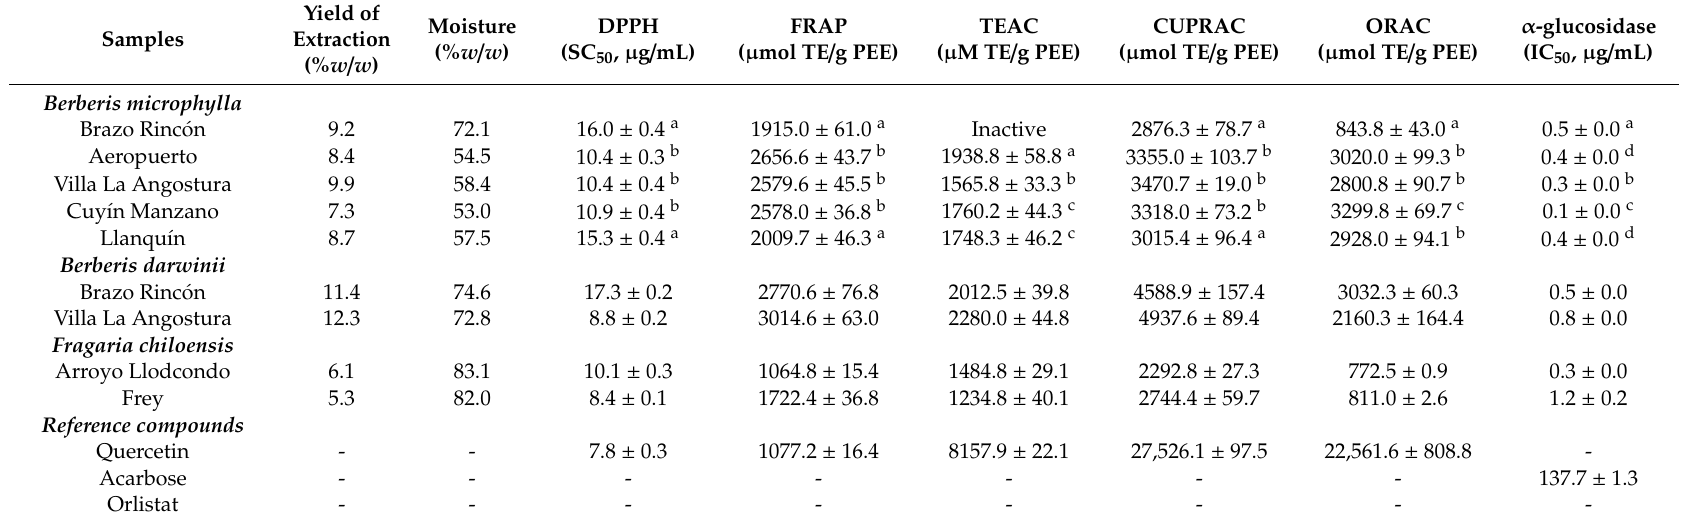
Table 1. Antioxidant capacity and inhibition of metabolic syndrome-associated enzymes by the phenolic enriched extracts (PEE) of wild berries from Argentinean Patagonia. DPPH = 2,2-diphenyl-1-picrylhydrazyl radical, FRAP = ferric-reducing antioxidant power, CUPRAC = cupric-reducing antioxidant power, ORAC = oxygen radical absorbance capacity, TEAC = Trolox equivalent antioxidant